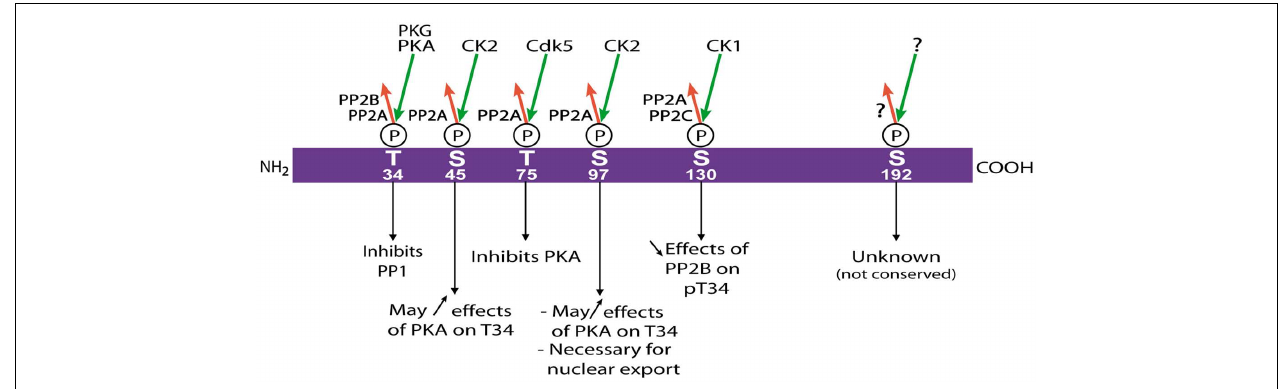
FIGURE 3 | Multisite phosphorylation of DARPP-32. Schematic representation of mouse DARPP-32 with the residues that have been found phosphorylated in vivo (Thr-34, Ser-45,Thr-75, Ser-97, Ser-130, Ser-192).The identified kinases are indicated above green arrows (phosphorylation), and protein phosphatases beside the red arrows (dephosphorylation).The role of the phosphorylation is given for each residue. See the text for discussion and references. P,